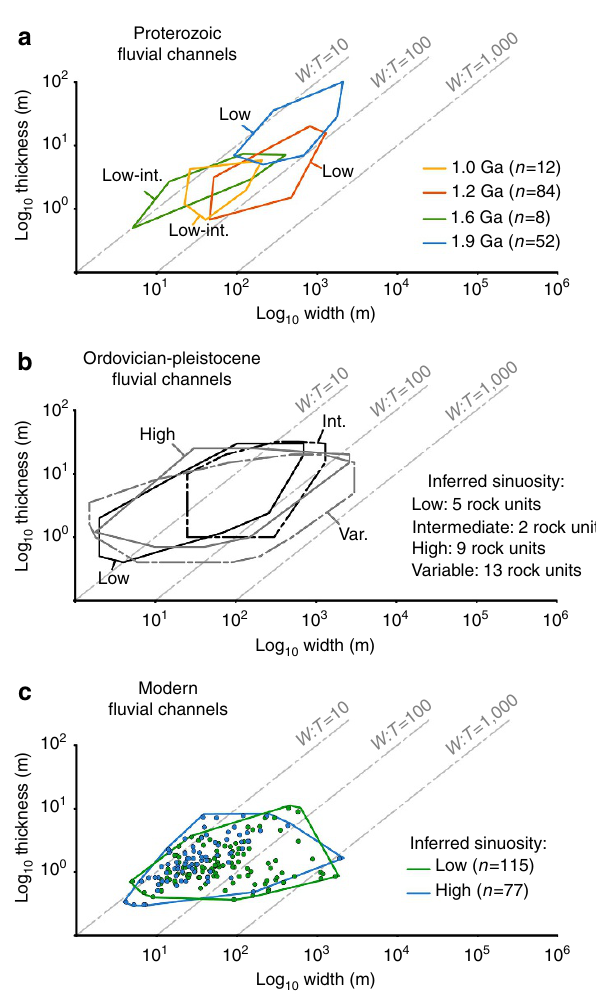
Figure 5 | Morphometric comparisons between pre- and post-vegetation channel forms. ( a ) Collective envelopes 12 constructed from the database of 156 channel forms. Inferred sinuosity of each unit is reported. ( b ) Collective envelopes for Ordovician to Pleistocene channel forms found in 29 rock units worldwide (Supplementary Data 2 and Supplementary Figs 1–4), grouped based on inferred sinuosity. ( c ) Data points and collective envelopes for 192 modern alluvial cross-section measures along perennial rivers not modified by anthropic activity (Supplementary Data 2 and Supplementary Fig. 5), grouped based on